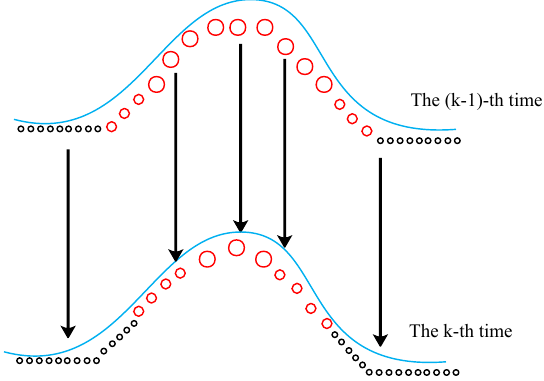
Figure 3. Schematic diagram of particle